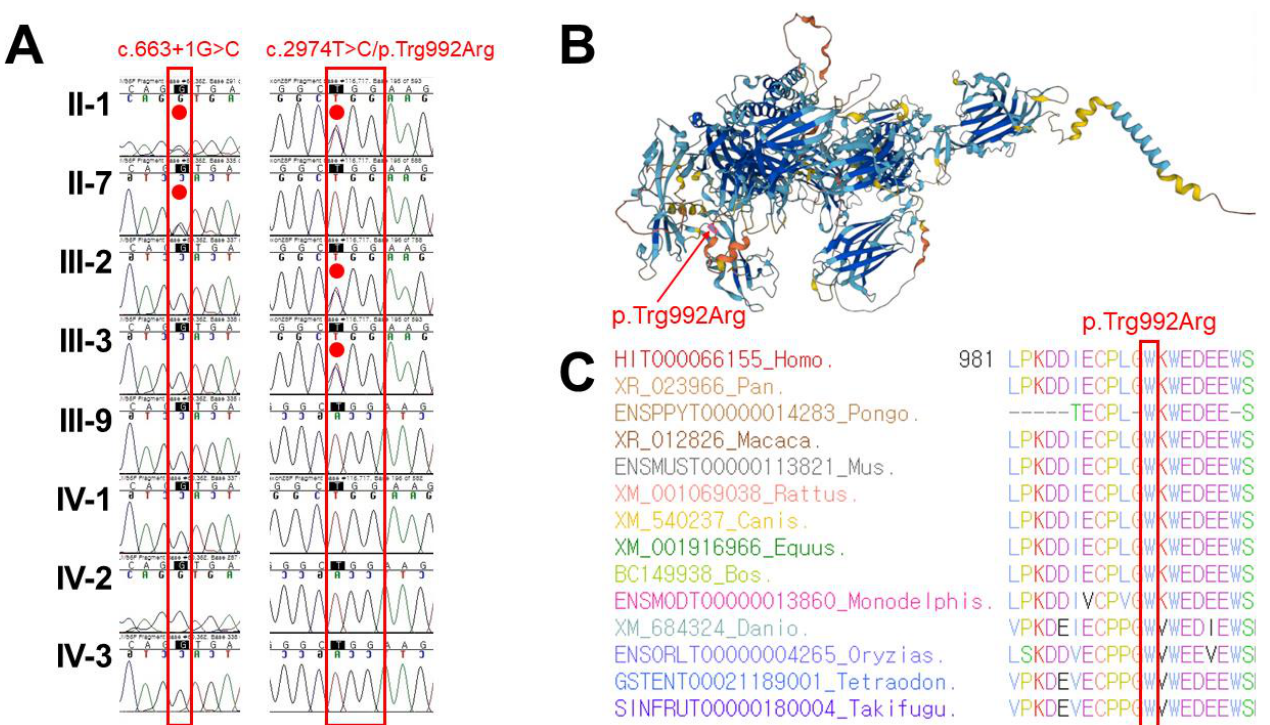
Figure 2. Sanger sequencing, protein structure prediction, and conservation comparison of the p.Trp992Arg variant of the DYSF gene. ( A ) Sanger sequencing confirmation of occurrence of the compound heterozygous DYSF variants c.663 + 1G > C and c.2974T > C; p.Trp992Arg as a consequence of autosomal recessive inheritance in the proband (II-1), which is highlighted with the red dot. ( B ) Protein structure study using AlphaFold shows very high per-residue confidence metric called predicted local distance difference test (pLDDT) of 83.37 for p.Trp992Arg of the DYSF gene. The protein residue of p.Trp992 is highlighted in pink and indicated by a red arrow. ( C ) Sequence alignments of the DYSF protein in several vertebrate species. The protein sequence of the Trp992 residue is conserved highly across the compared species between Human (HIT000066155_Homo) and Takifugu (SINFRUT00000180004_Takifugu), which is highlighted with the red box.